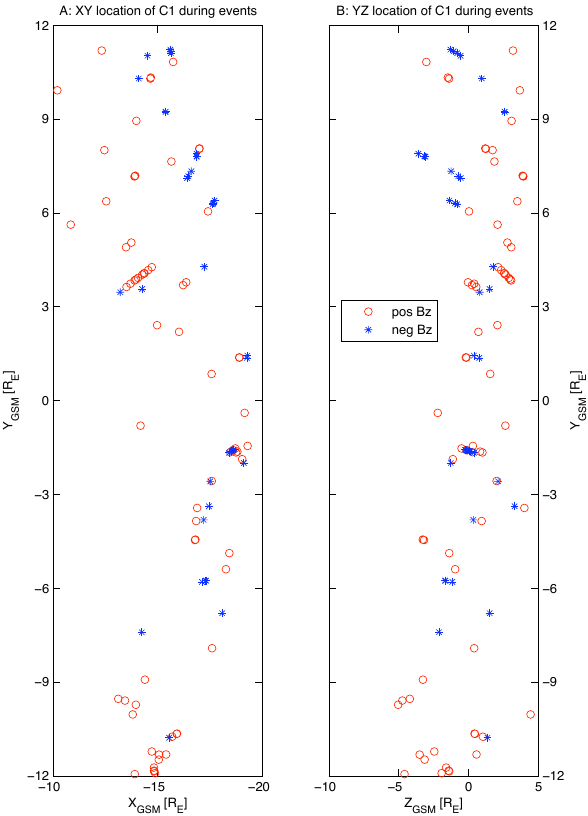
Fig. 1. Cluster spacecraft position in the XY and YZ plane for the 107 earthward flow events observed during the years 2001-2007. The 69 events with positive minimum B z values are marked by cir- cles. The 38 events with negative minimum B z values during the dipolarization are marked by